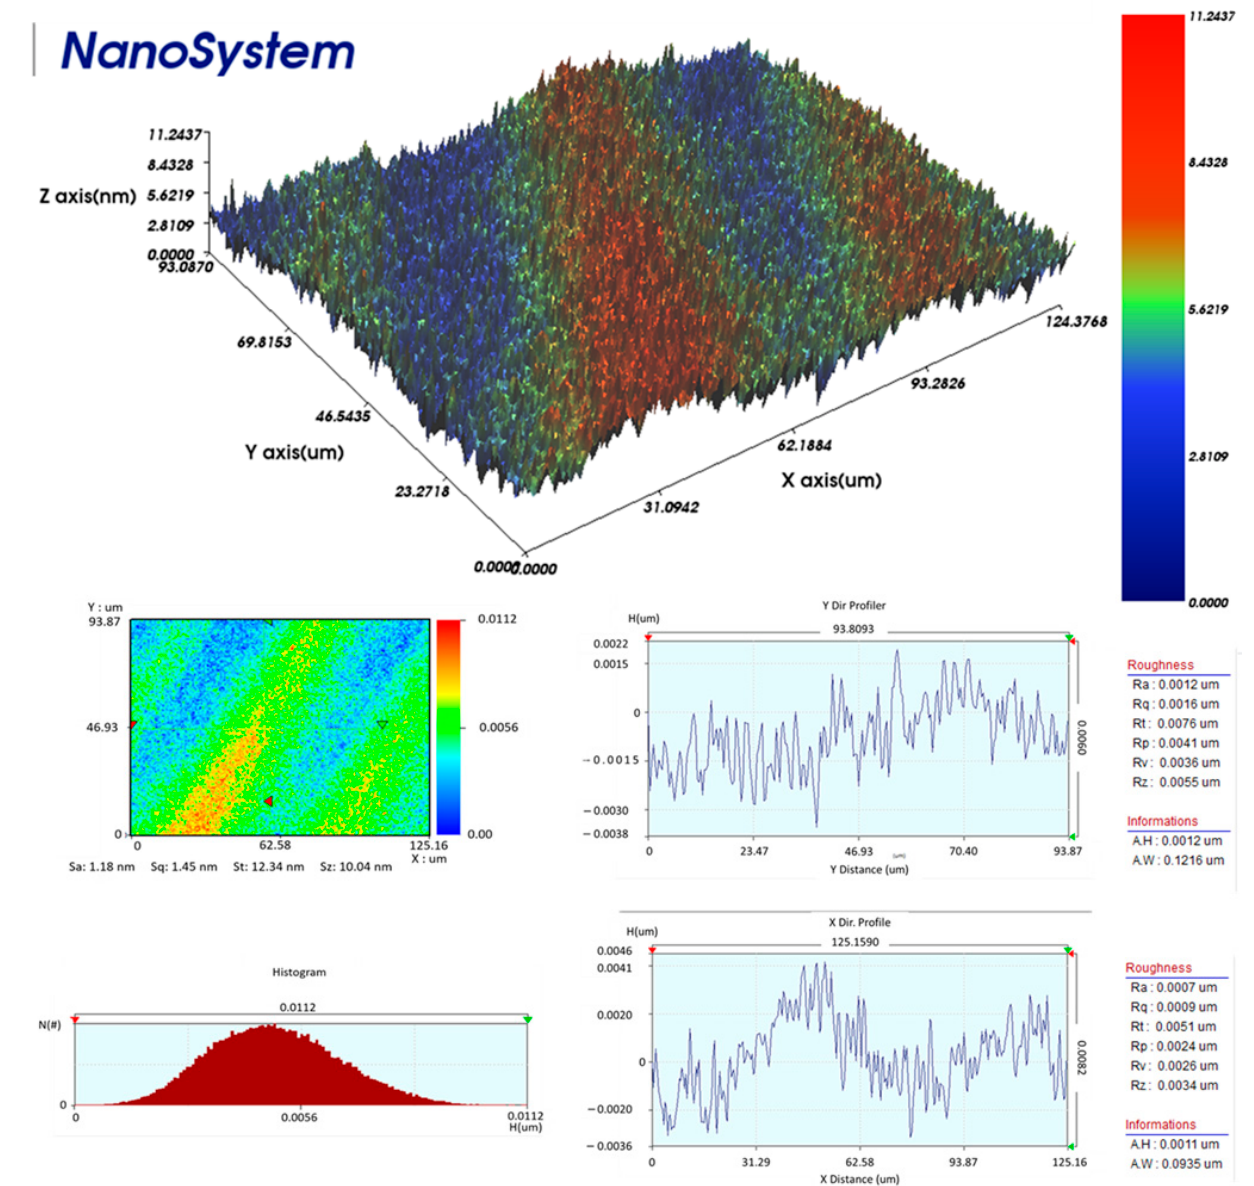
Figure 4. Morphological characterization results obtained from 3D nanoprofiler illustrating surface roughness of egg white thin film.